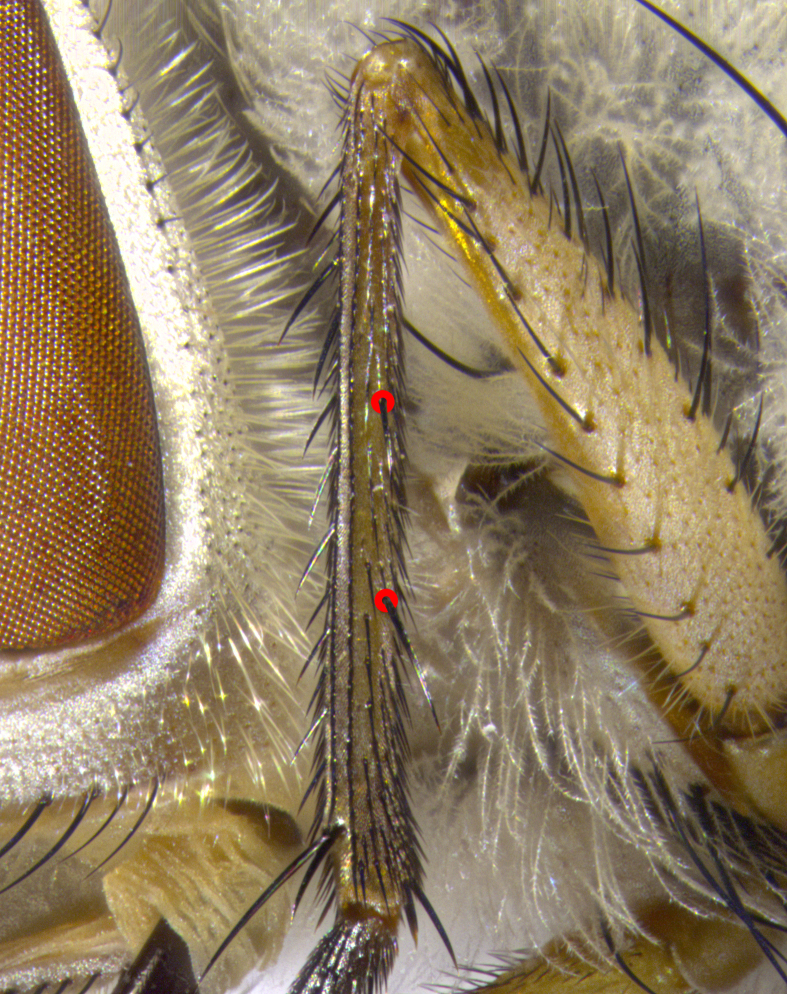
Telothyria
manuelpereirai
sp. n.